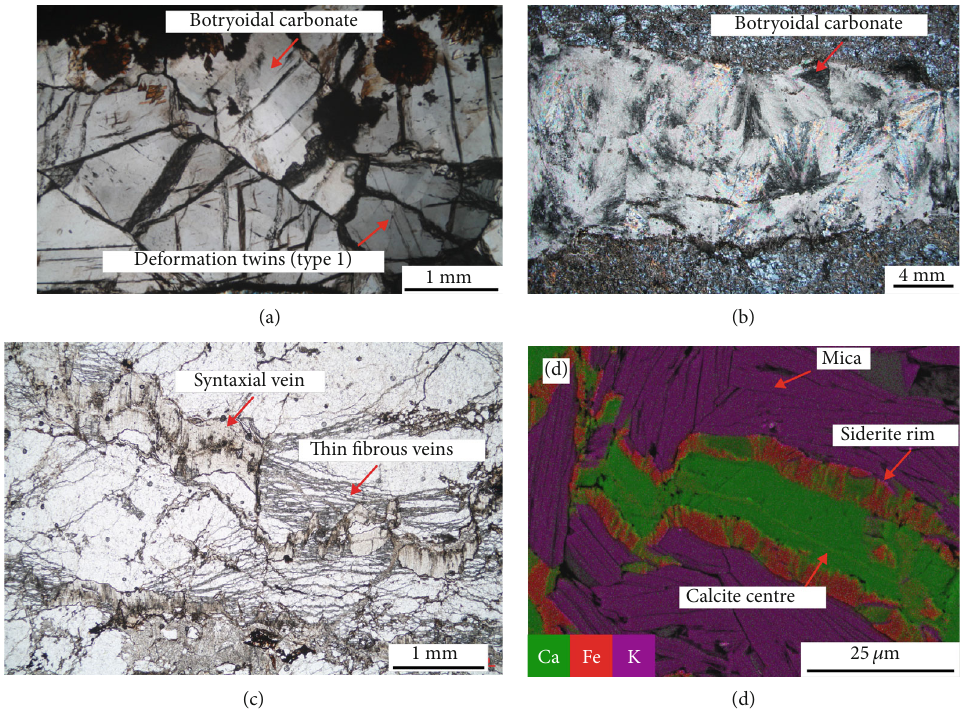
Figure 6: Microstructures of hydrothermal carbonate veins. (a) Botryoidal carbonate with rhombohedral cleavage and rare deformation twins (type 1) collected from Akatore Creek. (b) Botryoidal carbonate, from Bruce Rocks, with radiating grains fracturing parallel to the vein surface, without any sign of deformation twins. (c) Syntaxial veins and small fi brous veins in a quartzofeldspathic layer from the altered greyschist. (d) Ca, Fe, and K element map of a symmetric syntaxial vein in a mica-rich greyschist layer, showing a siderite rim and calcite